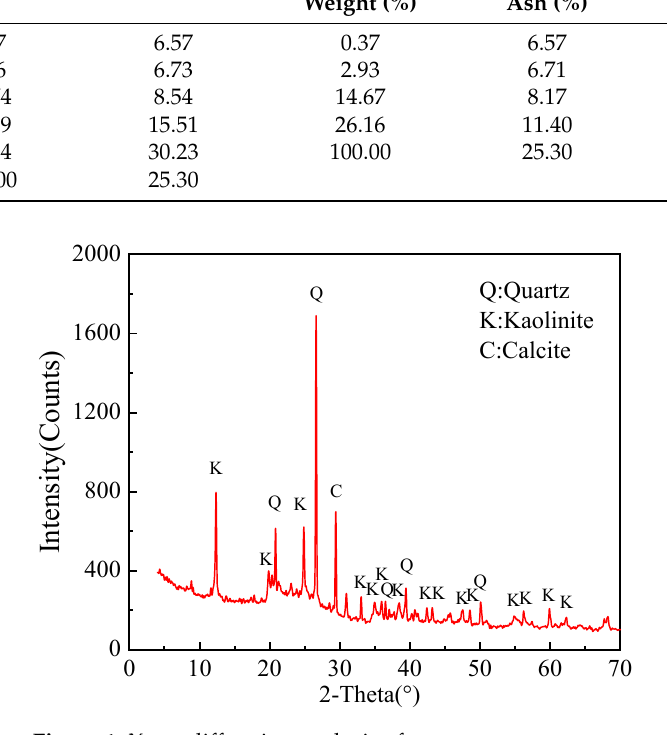
Figure 1. X - ray diffraction analysis of gangue. Figure 1. X-ray diffraction analysis of